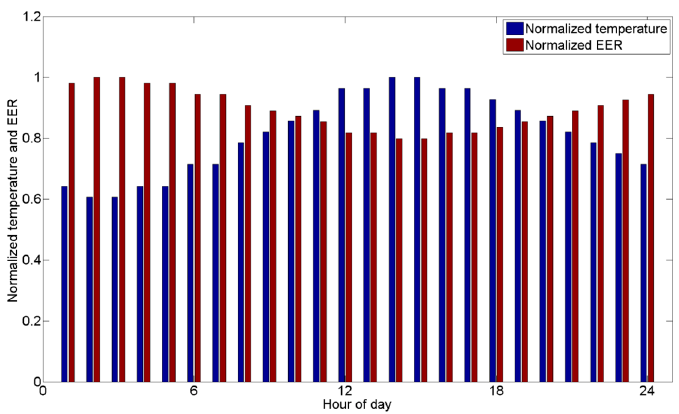
Figure 2. Non-dimensional temperature and EER profiles.